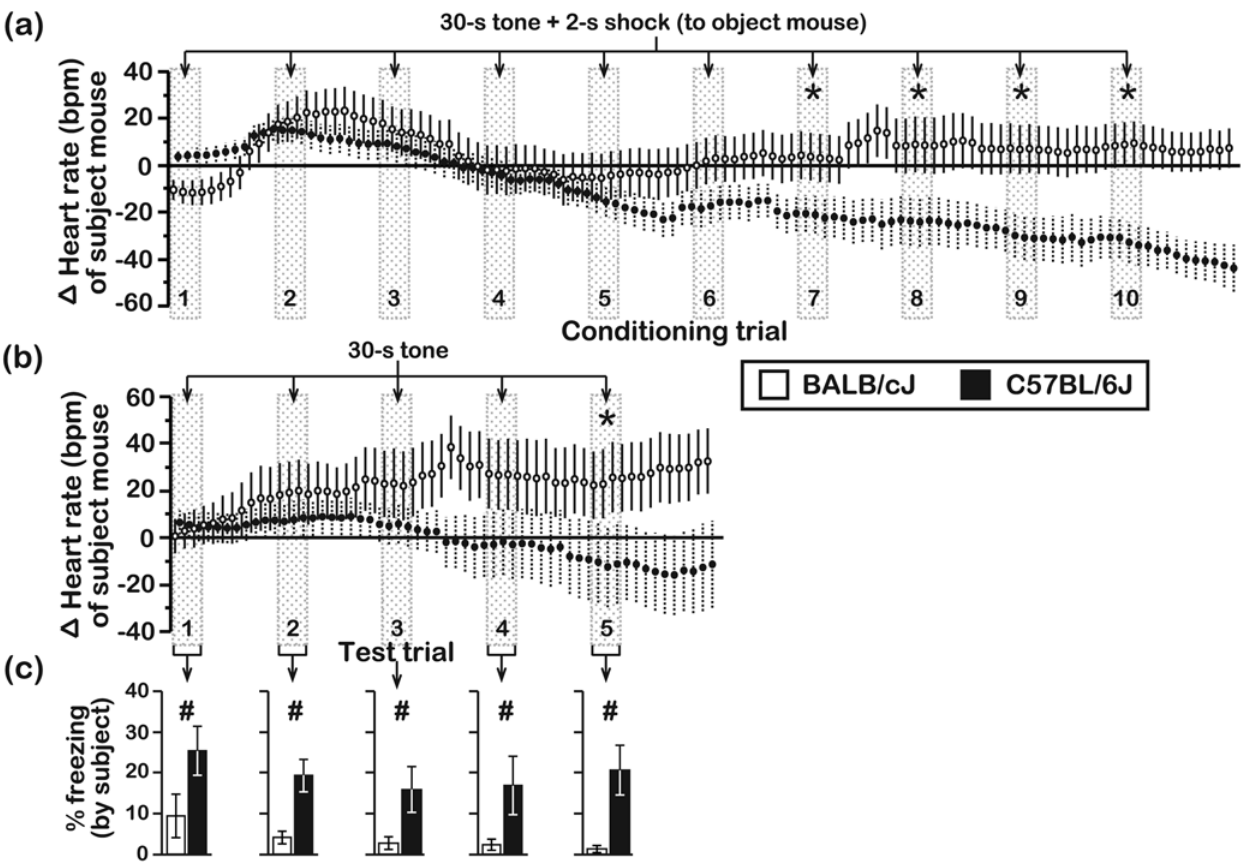
Figure 9. Heart rate changes of subjects during pre-exposure to objects that were conditioned with the CS-UCS and during testing with the CS-only. HR was measured during (a) the first and second conditioning session in subjects that experienced objects receiving the paired CS-UCS, and during (b) testing, which entailed 5 repeated presentations of the CS-only. HR changes in subjects from both strains were similar across the 2 conditioning sessions and therefore pooled for graphical presentation. Each data point represents a 10-s bin. HR is presented as a change ( D ) from the baseline HR of each mouse (see Table 2). (c) Conditioned freezing responses of subjects during presentation of the CS-only (N=15 subjects/ genotype; age=7–9 wks). Asterisks represent significant (P , 0.05) HR differences between BALB and B6 subjects. Numeric symbols represent significant (P , 0.05) differences in freezing between BALB and B6 subjects. Behavioral data were scored in duplicate by 2 independent raters and all data are presented as the mean 6 s.e.m.. Inter-rater reliability, r p =0.94,